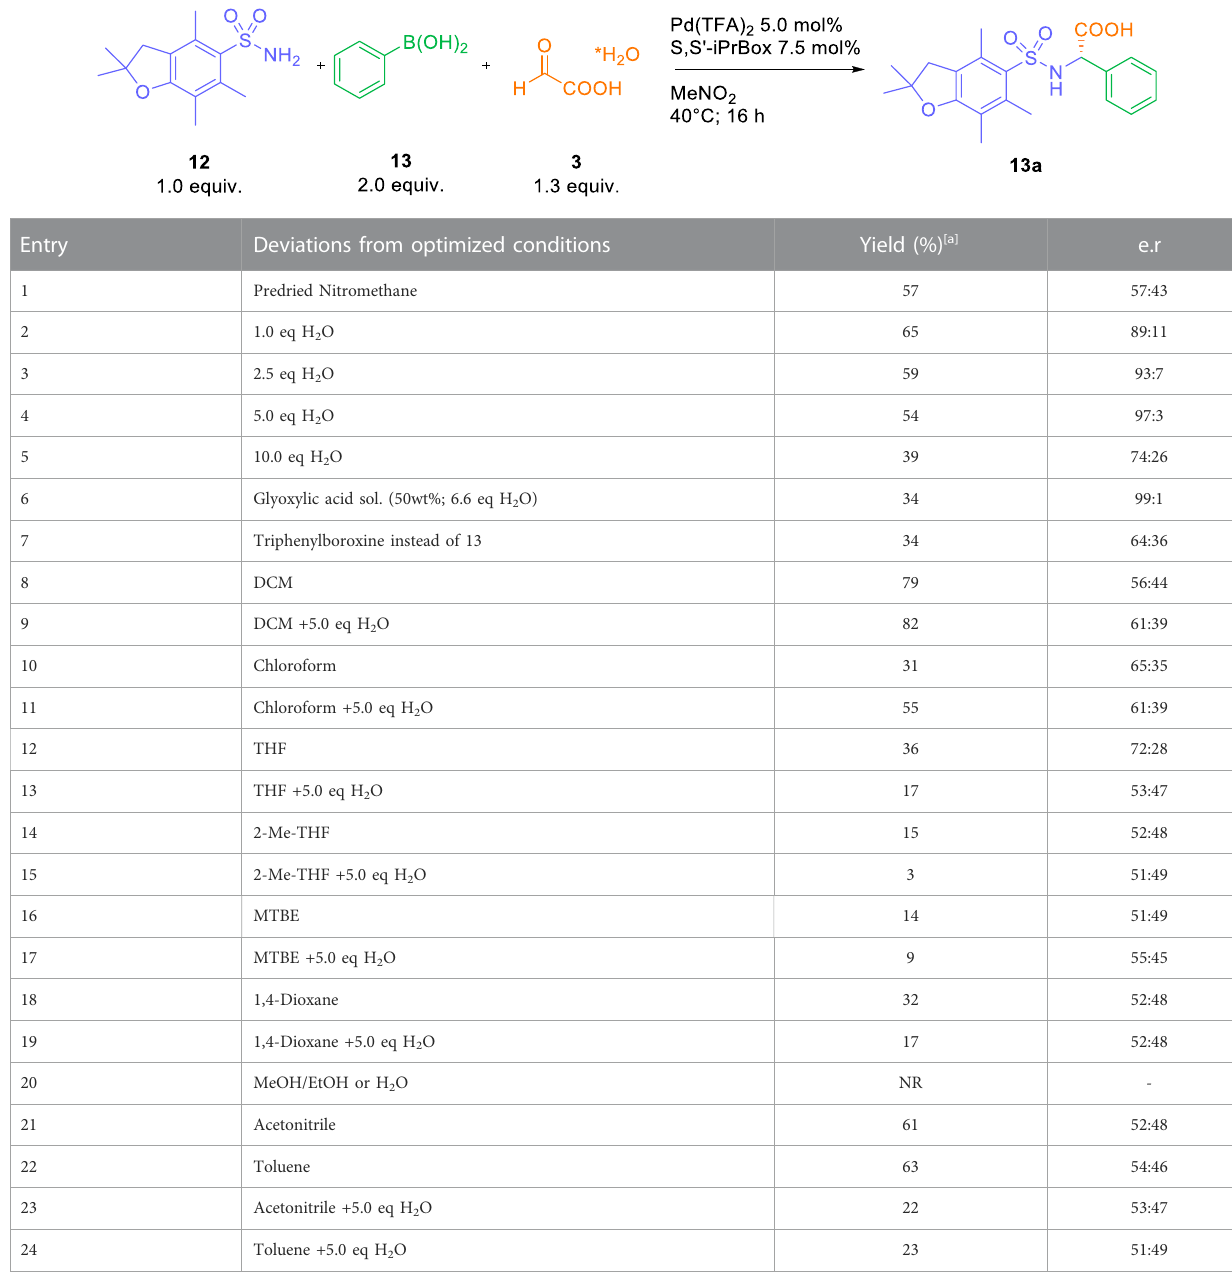
TABLE 1 Initial experiments and solvent